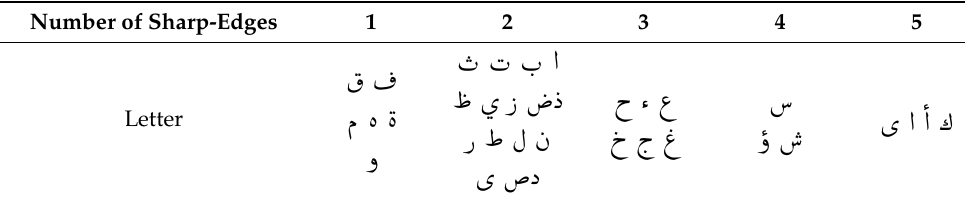
Table 14. Number of sharp edges for each letter (Adapted from [105]).